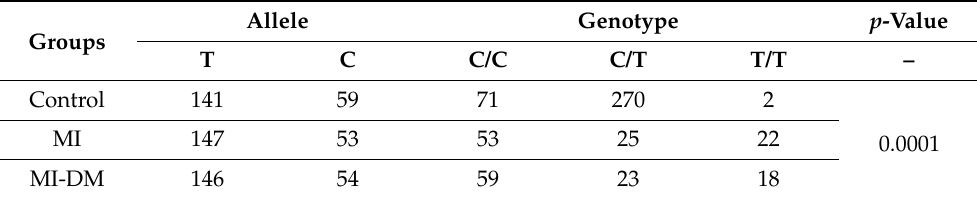
Table 4. Genotype and allelic frequency of MTHFR C677T (rs1801133) gene polymorphism